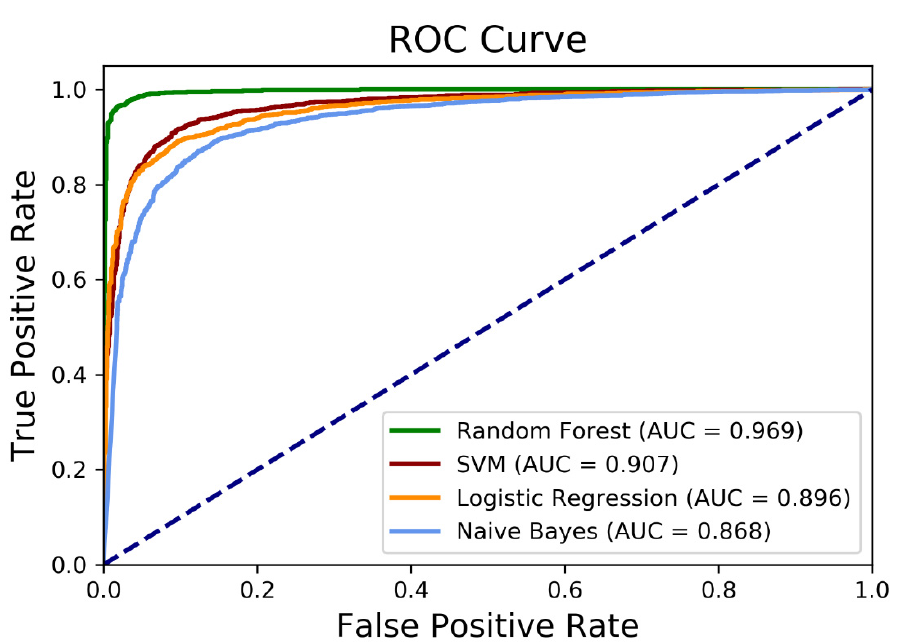
Figure 4. Receiver operating characteristic (ROC) curves for the classification. AUC = area under the ROC curve. Additional details are provided in Supplementary Table S2.